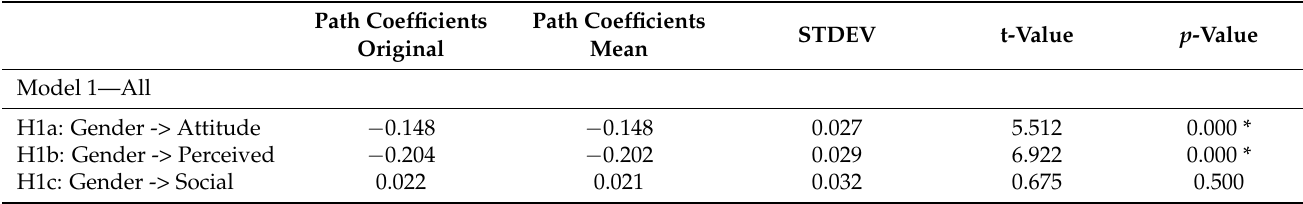
Figure 5. Bootstrap analysis to model 1 (all). Table 5. The significance